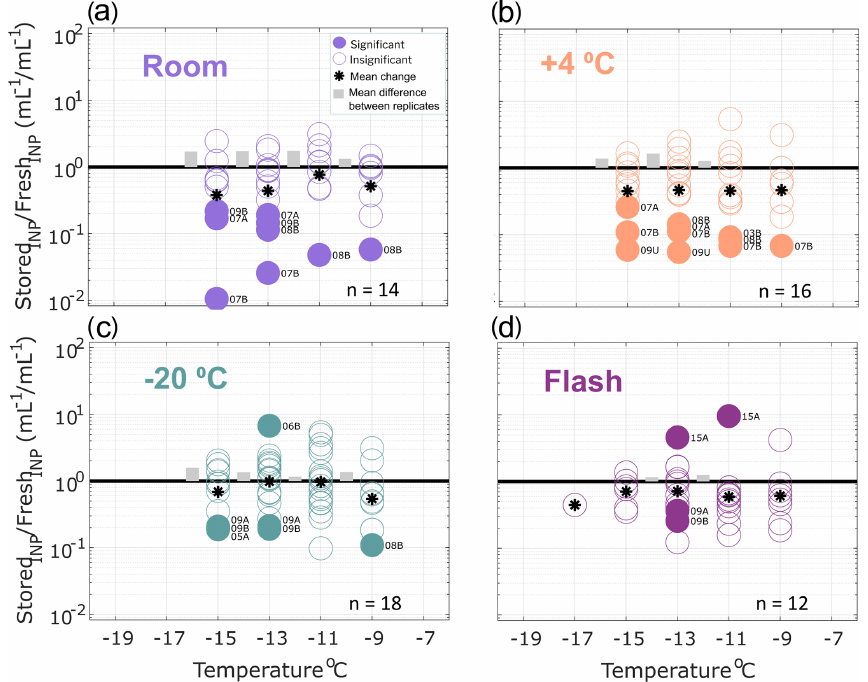
Figure 2. Ratio of INP concentrations measured in untreated precipitation samples (stored:fresh), calculated in successive 2 ◦ C incre- ments between − 19 and − 7 ◦ C. Four storage protocols were applied: (a) room temperature (21–23 ◦ C), (b) refrigerated ( + 4 ◦ C), (c) frozen ( − 20 ◦ C) and (d) flash frozen in liquid nitrogen before storing frozen ( − 20 ◦ C). All samples were processed at one or two time intervals between 1 and 166d postcollection (see Figs. S1–S4). For samples processed at two intervals, both replicate samples are represented in the figure for a total of 14, 16, 18 and 12 samples in panels (a) , (b) , (c) and (d) , respectively (see Table 2 for summary of sample and replicate numbers). Markers above the black 1:1 line indicate enhancement of INP concentrations in stored samples, and markers below indicate losses. In temperature intervals containing stored:fresh ratios from at least two sets of replicate samples, grey bars represent the average difference between replicates. Stored sample frozen well fractions that passed Fisher’s exact test ( p < 0.01) for significant differences from original fresh sample frozen well fractions at each of the five temperatures are indicated with filled markers, and the mean change in each temperature interval is marked with a star. Significant data are also labeled to indicate the sample number (01–15; see Table 1) and replicate (“A” or “B”, and “U” indicates there were no replicates for the sample). Results show that, on average, INP concentrations decrease in stored samples and that both room temperature storage and refrigeration result in significant INP losses. Frozen and flash-frozen storage show comparable results, with fewer (3–4) of the observations exhibiting significant losses and enhancements in INP